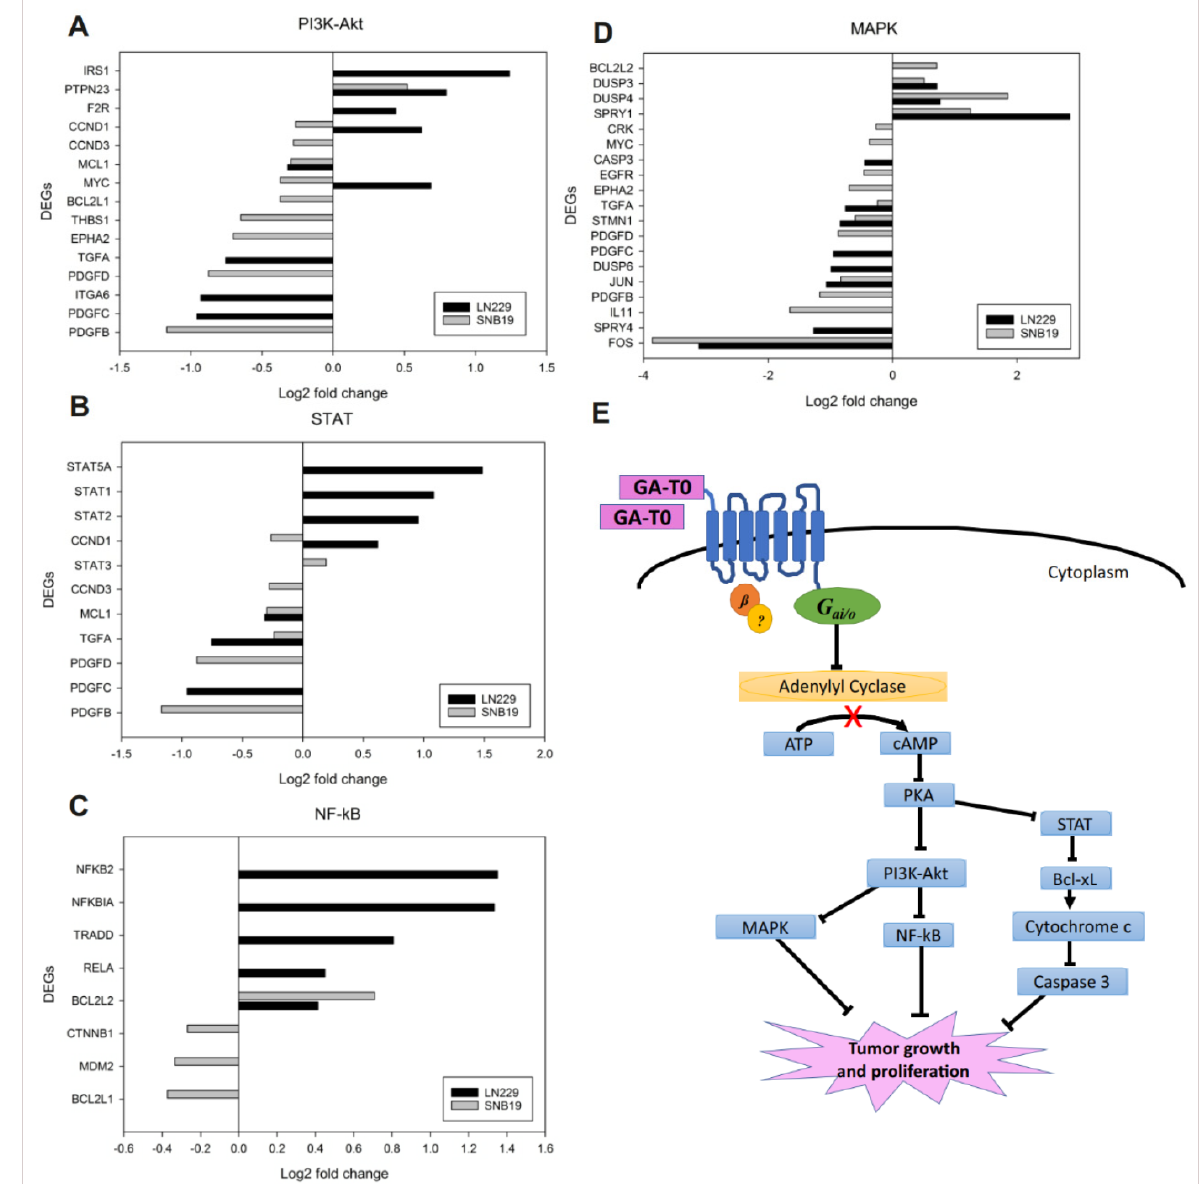
Figure 4. Regulation of signal transduction pathways upon GA–T0 treatment . ( A ) Key DEGs associated with the PI3K–Akt, ( B ) STAT, ( C ), NF- κ B, and ( D ) and MAPK pathways. ( E ) Schematic overview of signal transduction pathway modulation upon the binding of GA-T0 on the GPR17 receptor in GBM